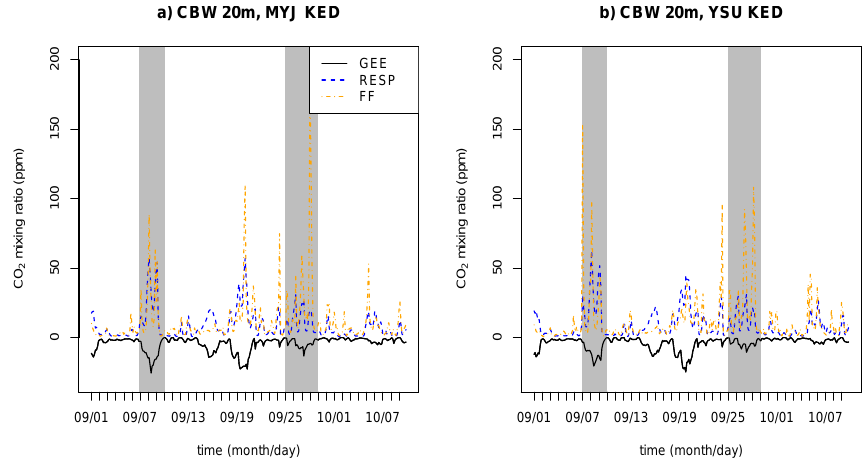
Figure 9. Simulated CO 2 tracers for the vegetation signal Gross Ecosystem Exchange (GEE, black line), respiration (RESP, blue dashed line) and the fossil fuel tracer (FF, orange dash dotted line) at Cabauw 20m (a.g.l.) from the MYJ KED STILT simulation (a) and the YSU KED simulation (b) . The grey areas indicate the occurrence of two events characterized by comparably large model errors: period 1 (7 to 9 September 2009) and period 2 (25 to 28 September 2009). Airflow in both periods is qualitatively different, resulting in a strong vegetation signal in period 1 while in period 2 the FF signal dominates. In these periods quantitative model–model differences are notable although the same surface fluxes were